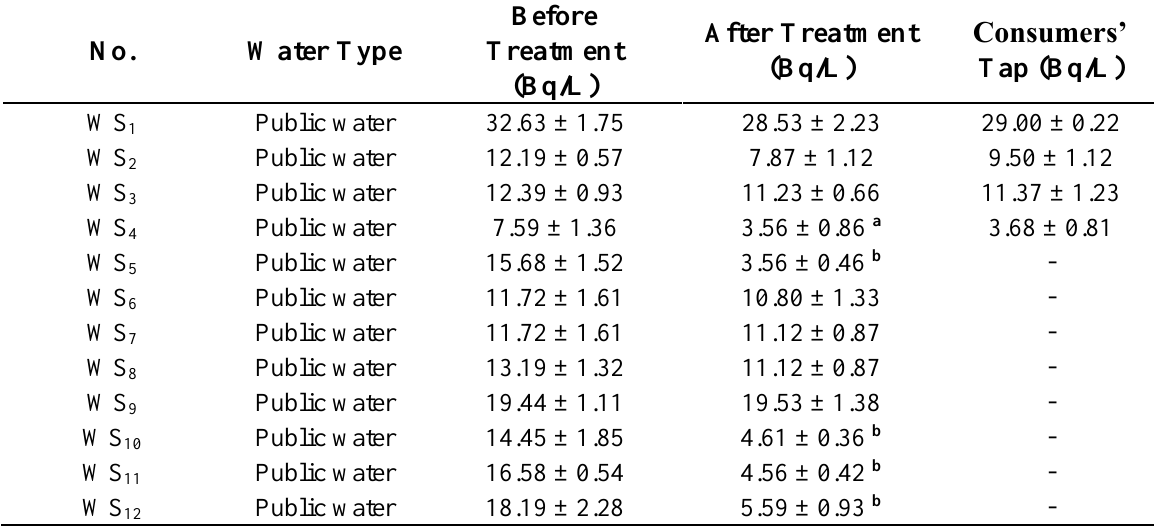
Table 3. Radon concentrations for samples taken at different locations in water